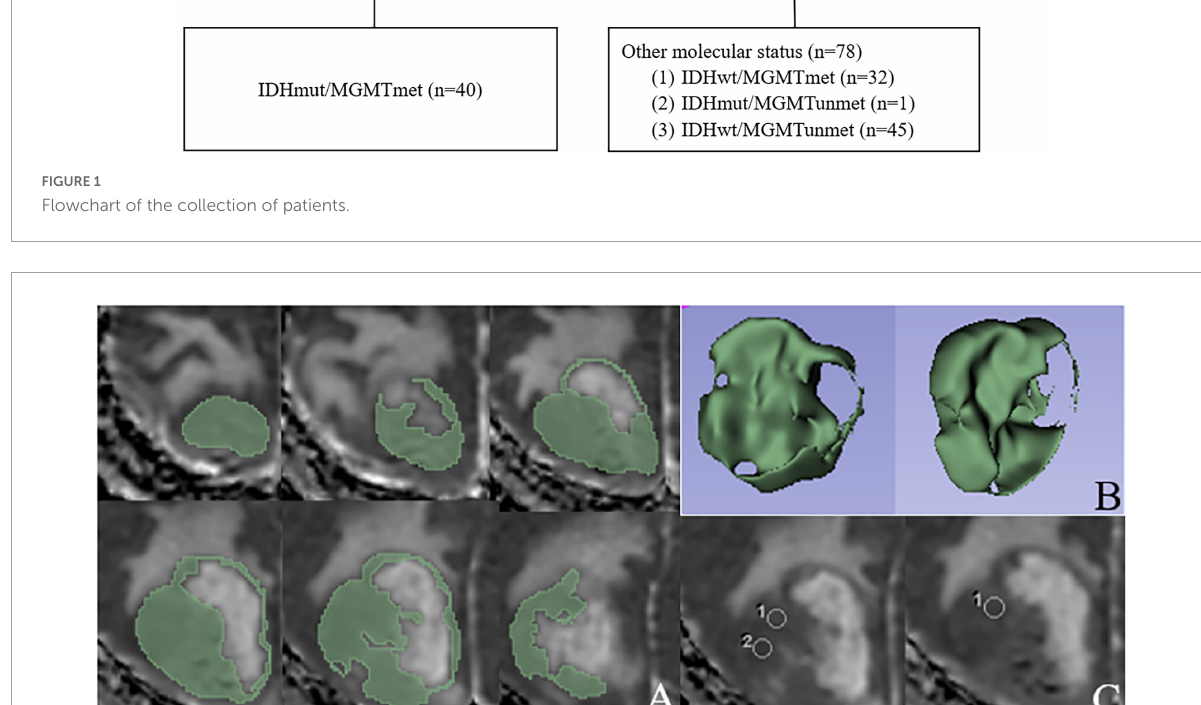
FIGURE2 An example of ROIs delineated based on ADC histogram analysis and direct measurements, respectively. (A) ROIs manually delineated in solid components layer by layer on ADC map. (B) Three-dimensional stereogram generated by 3D Slicer software after the tumor segmentation. (C) Three rounded ROIs in solid components of the tumor based on the direct ADC